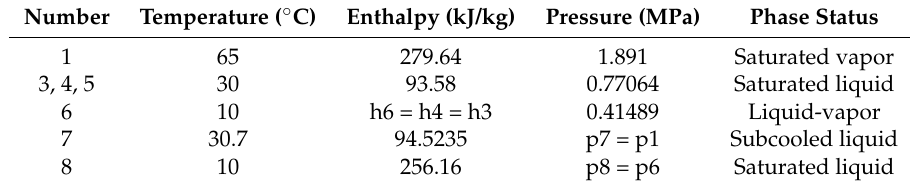
Table 2. Cooling cycle